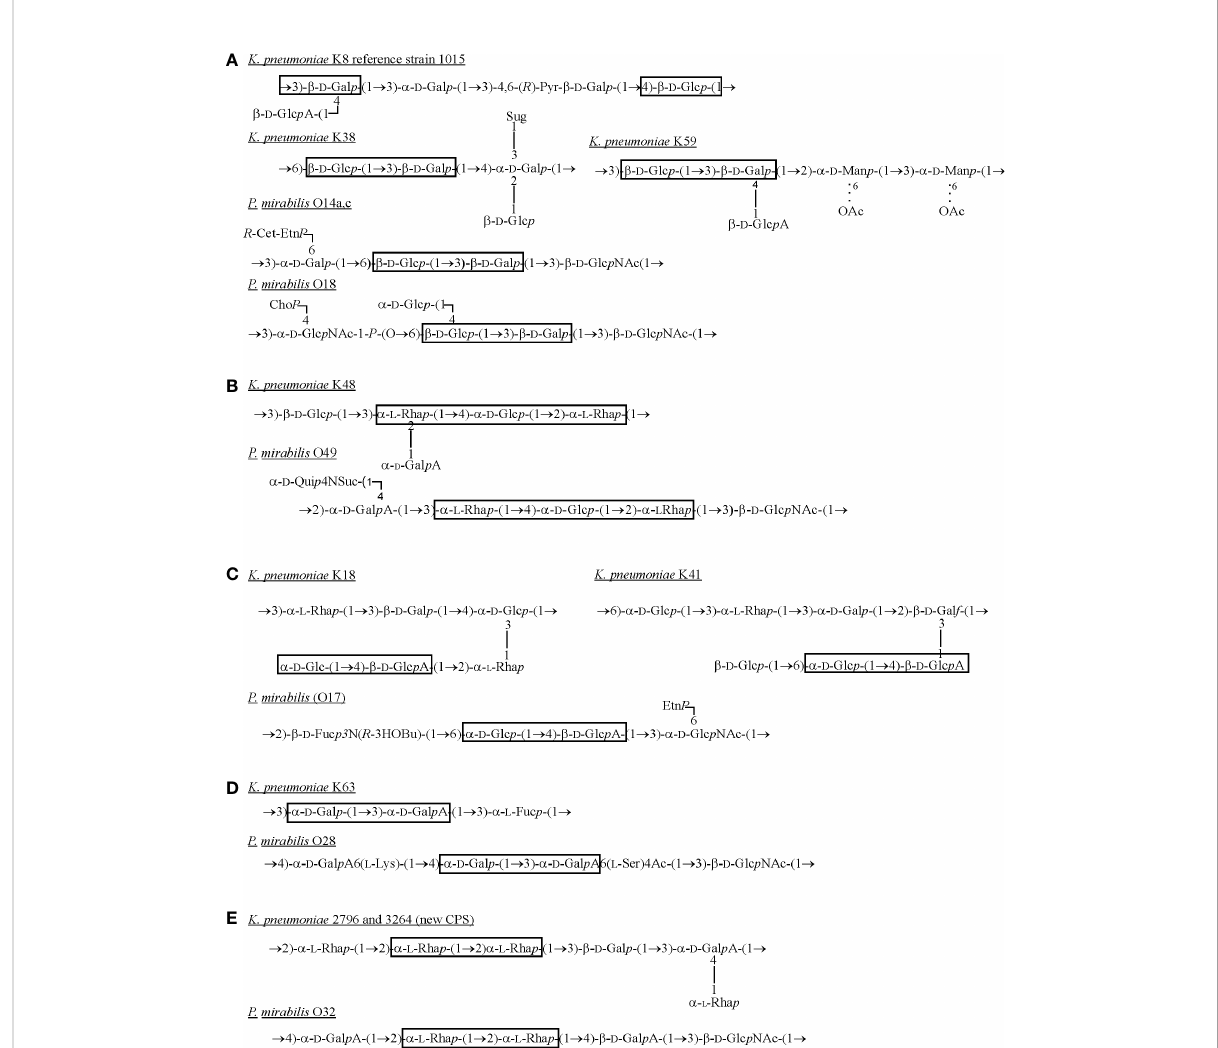
FIGURE 3 Structures of K. pneumoniae capsular polysaccharides and P. mirabilis OPSs (A – E) sharing the common fragments (in frames) (Lindberg et al., 1975; Dutton et al., 1978; Joseleau et al., 1978; Joseleau and Marais, 1979; Joseleau and Marais, 1988; Jansson et al., 1994; Erbing et al., 1995; Knirel et al., 2011; Kubler-Kielb et al., 2013). Dotted lines indicate that some of the residues are O -acetylated. Cho P , choline phosphate; Etn P , ethanolamine phosphate; Fuc, fucose; D-Fuc3N, 3-amino-3-deoxy-D-fucose; Gal f , galactofuranose; Gal p , galactopyranose; GalA, galacturonic acid; Glc, glucose; GlcA, glucuronic acid; D-GlcNAc, 2-acetamido-2-deoxy-D-glucose; L-Lys, L-lysine; Man, mannose; Pyr – pyruvic acid; R - 3HOBu, ( R )-3-hydroxybutanoic acid; R -Cet-Etn P , N -[( R )-1-carboxyethyl]ethanolamine phosphate; Rha, ramnose; L-Ser, L-serine; Suc, succinic acid; Sug, 4-deoxy- threo -hex-4-enopyranosyluronic acid group; Qui4N,